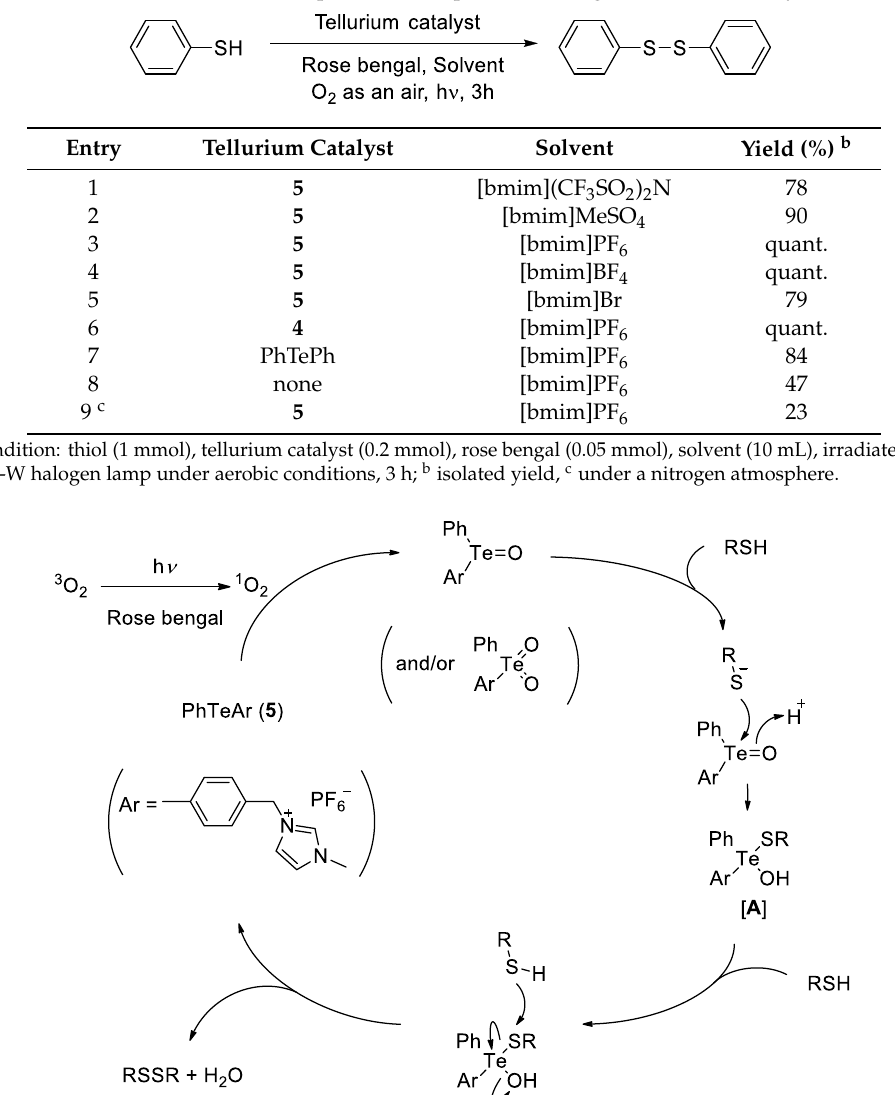
Table 2. Catalytic oxidation of various thiols using IL-supported diphenyl telluride 5 a .